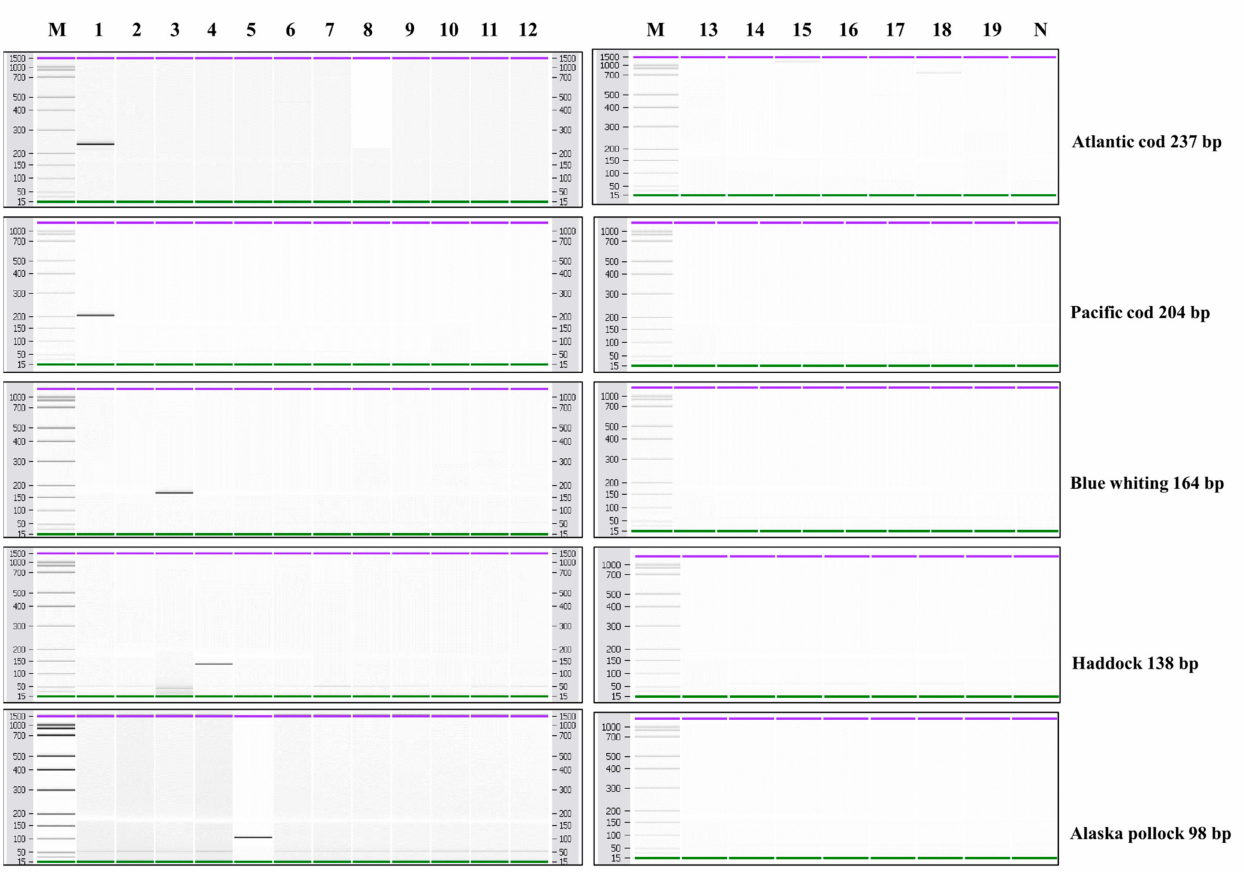
Figure 1. Specificity of the specific-species primers of Atlantic cod, Pacific cod, blue whiting, haddock, and Alaska pollock. Lane M: 100 bp DNA ladder, lane 1: Atlantic cod, lane 2: Pacific cod, lane 3: blue whiting, lane 4: haddock, lane 5: Alaska pollock, lane 6: common carp, lane 7: leather carp, lane 8: goldfish, lane 9: Chinese muddy loach, lane 10: snakehead, lane 11: Nile tilapia, lane 12: Pacific saury, lane 13: Pacific chub mackerel, lane 14: longtooth grouper, lane 15: convict grouper, lane 16: Atlantic salmon, lane 17: masu salmon, lane 18: swordfish, lane 19: Patagonian toothfish, lane N: